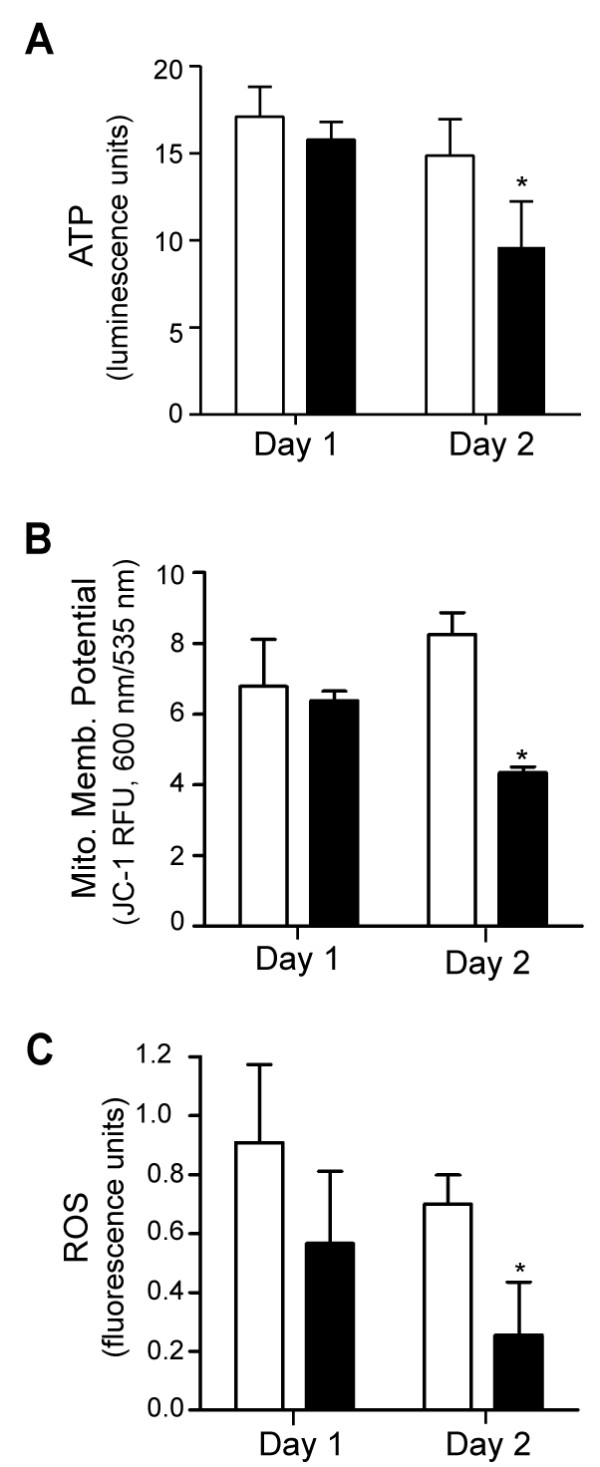
Deficiency of mitochondrial energy metabolism accompanies cell death in cells treated with MIPP. For all graphs the solid bars are values for cells treated with 10 μM MIPP and the open bars are controls treated with an equivalent volume of DMSO. A) ATP levels were measured as described in the Methods. The decrease in ATP in MIPP-treated cells on day-2 (*) was significant at p < 0.02 compared to the cells treated with DMSO. B) Mitochondrial membrane potential was evaluated using the JC-1 assay. The significant decline (p < 0.0001) in the ratio of fluorescence emission at 600 nm vs. 535 nm on day-2 signifies a disruption of mitochondrial membrane potential. C) There is no increase in intracellular ROS associated with MIPP-induced cell death, based on measuring the fluorescence of the ROS indicator, H2DCFDA. The decline in ROS in the MIPP-treated cells on day-2 was significant at p < 0.005.